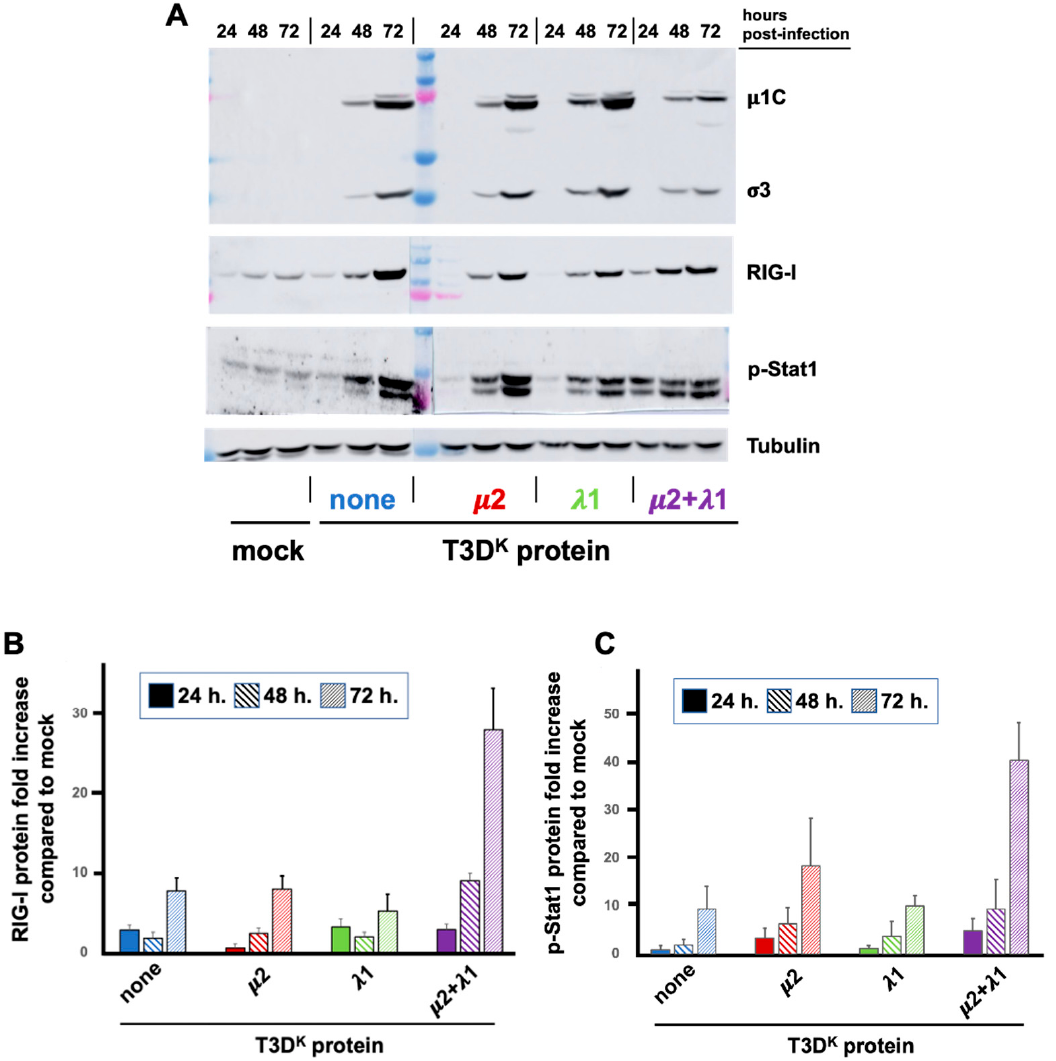
Figure 4. L929 cells were infected at a MOI of 0.05 TCID 50 units/mL with the different viruses in the T3D S genetic background with either no substitution (none) or substitution of the μ 2, λ 1, or both proteins of T3D K , as indicated and as described in Materials and Methods. Proteins were recovered from infected cells at different times post-infection (24, 48 and 72 h). ( A ) Immunoblotting analysis was performed against either virus proteins ( μ 1C and σ 3), RIG-I, phospho Stat1 or tubulin, as indi- cated. The results of a representative experiment is presented. ( B , C ) Immunoblots of three biological replicates were quantified for RIG-I in panel b and phospho-Stat1 in panel c; small correction from different loading, using tubulin was first used and then the increase in RIG-I or phospho-Stat1 was analyzed, taking into account the different amounts of viral proteins. The values obtained from T3D S with no protein from T3D K substituted were considered as “one” for all three different times.